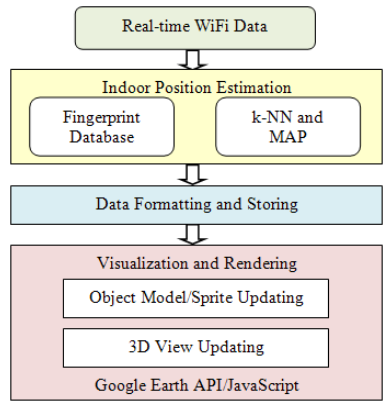
Figure 2. Overview of the process from indoor position estimation to visualization of the indoor positioning